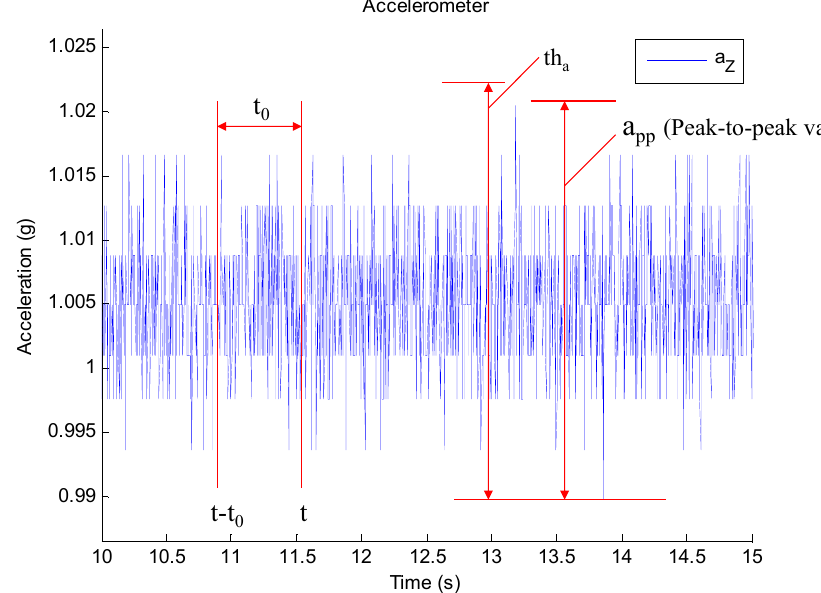
Figure 2. An example of collected z-axis acceleration in stationary state.